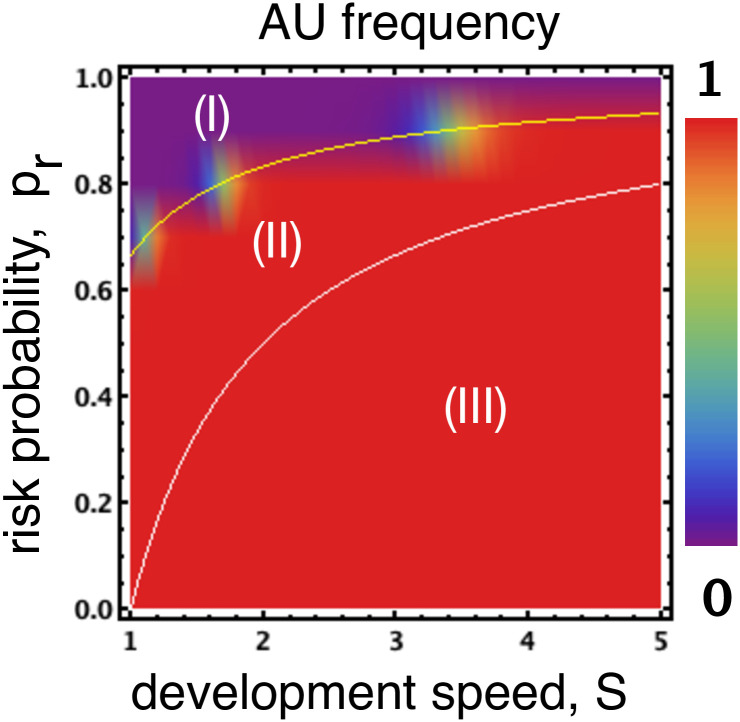
Frequency of AU in a population of AU and AS.Region (II): The two solid lines inside the plots delineate the boundaries pr ∈ [1 − 1/s, 1 − 1/(3s)] where safety compliance is the preferred collective outcome yet evolution selects unsafe development. Regions (I) and (III) display where safe (respectively, unsafe) development is not only the preferred collective outcome but also the one selected by evolution. Parameters: b = 4, c = 1, W = 100, B = 104, β = 0.01, Z = 100.